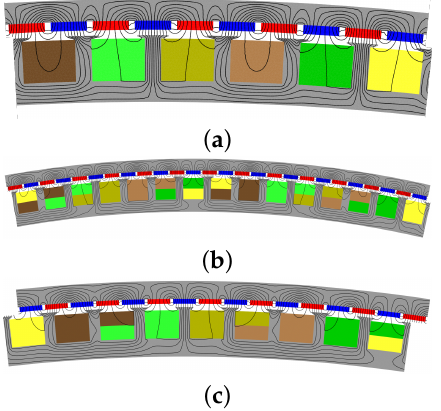
Figure 18. Cross sections of optimized 3MW Type-A PMVMs: ( a ) (1/40th) of Type-A PMVM with Qs/ps/pr = 240/40/200, ( b ) (1/16th) of Type-A PMVM with Qs/ps/pr = 240/32/208, ( c ) (1/25th) of Type-A PMVM with Qs/ps/pr = 225/25/200.